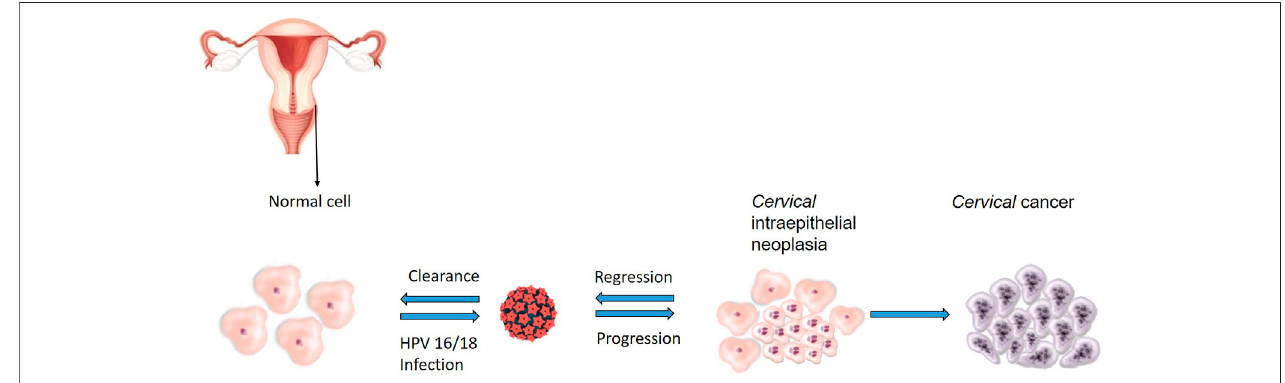
FIGURE 1 | Sequence of events leading to the development of HPV-related cervical cancer. Cervical intraepithelial neoplasia develop when squamous cells grow abnormally after persistent HPV infection, most of these changes resolve over time but in others, the integration of viral particles transforms cells and enables them to progress to the development cervical